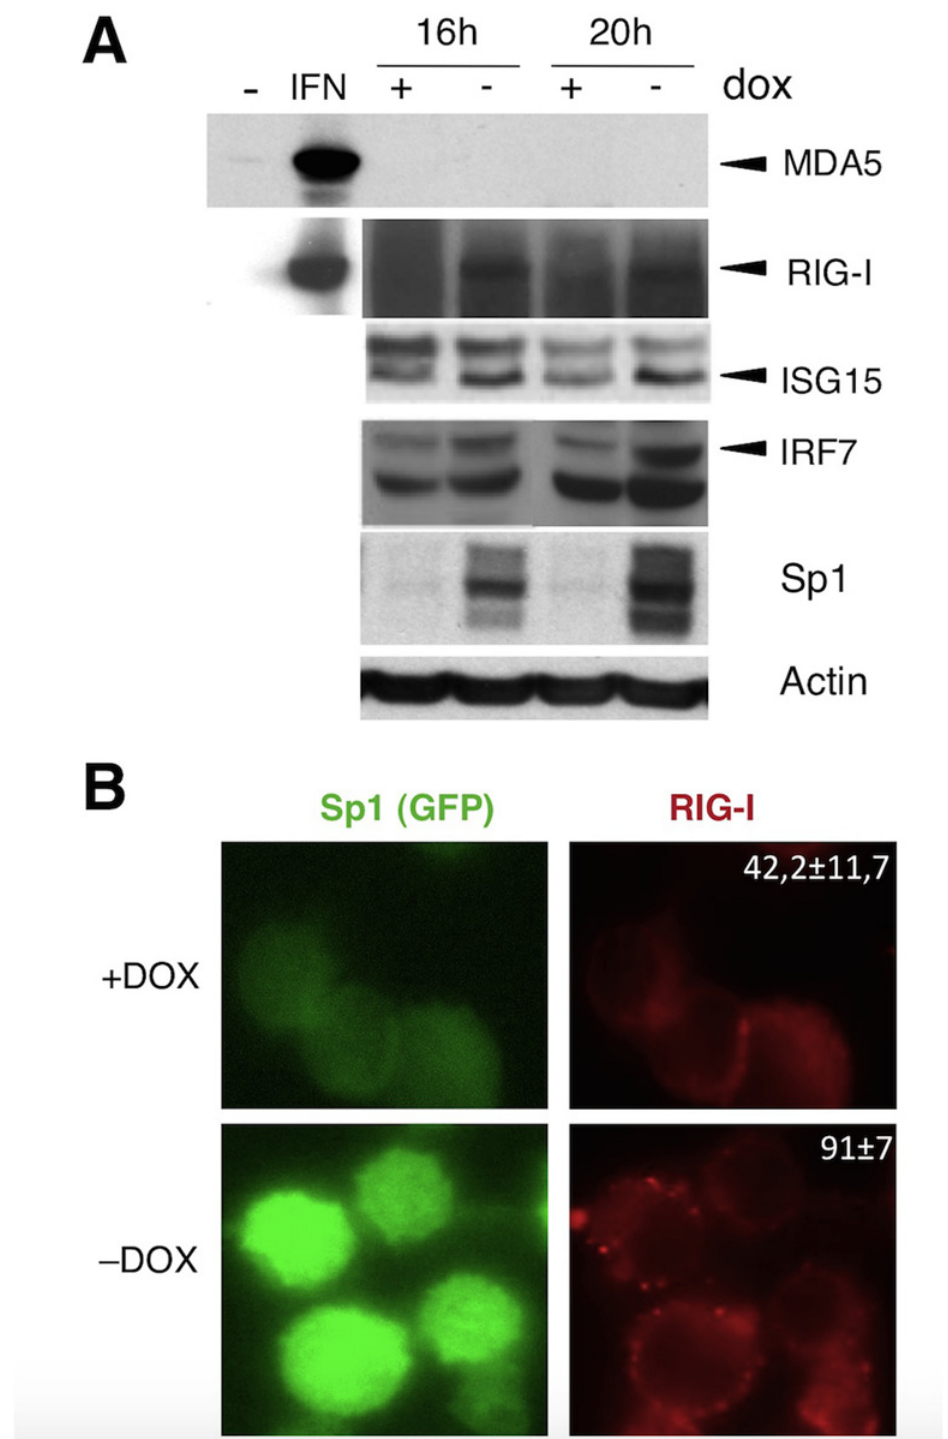
Fig 3. Proteins of the antiviral RIG-I pathway are induced by increased Sp1 level. BaF3-Sp1 cells were grown in the presence or absence of dox. (A) Cell extracts were collected at indicated time and expression of the indicated proteins was analyzed by immunoblot. A549 cells treated 16 h with IFNa (1000U/ml) were used as positive control (IFN) for MDA5 and RIG-I induction. (B) BaF3-Sp1 cells were cultured for 20 h, fixed and stained for RIG-I (red) and analyzed by fluorescent microscopy. The percentage of cells presenting